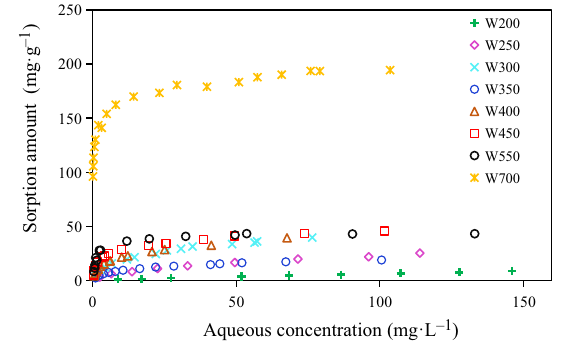
Fig. 5 Sorption isotherms of 1,3,5-trinitrobenzene on